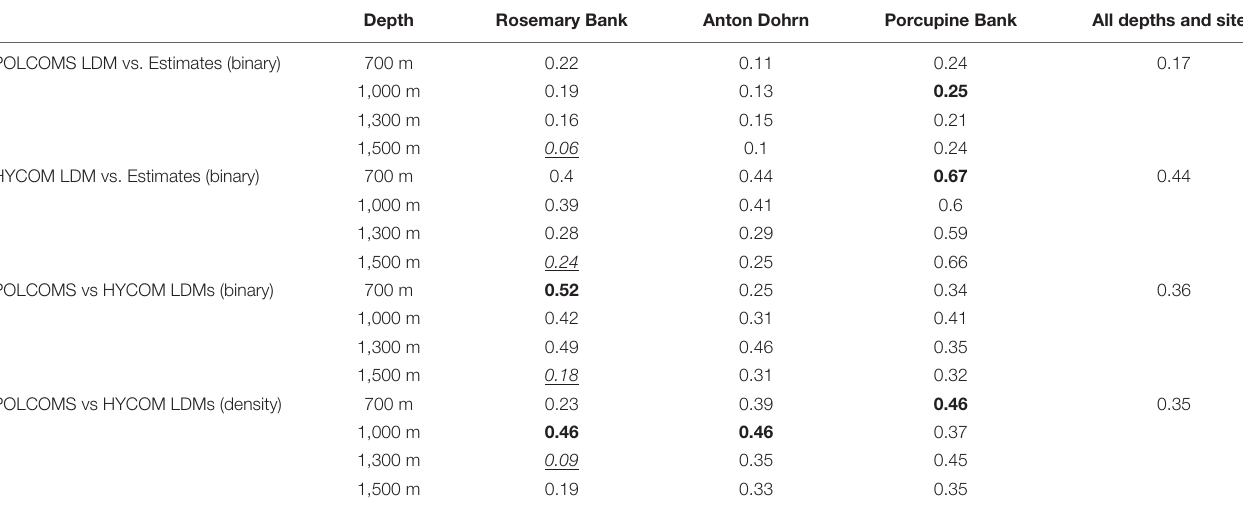
TABLE 2 | Linear correlation coefficients between predictions provide quantitative spatial comparisons between LDM and estimate predictions.